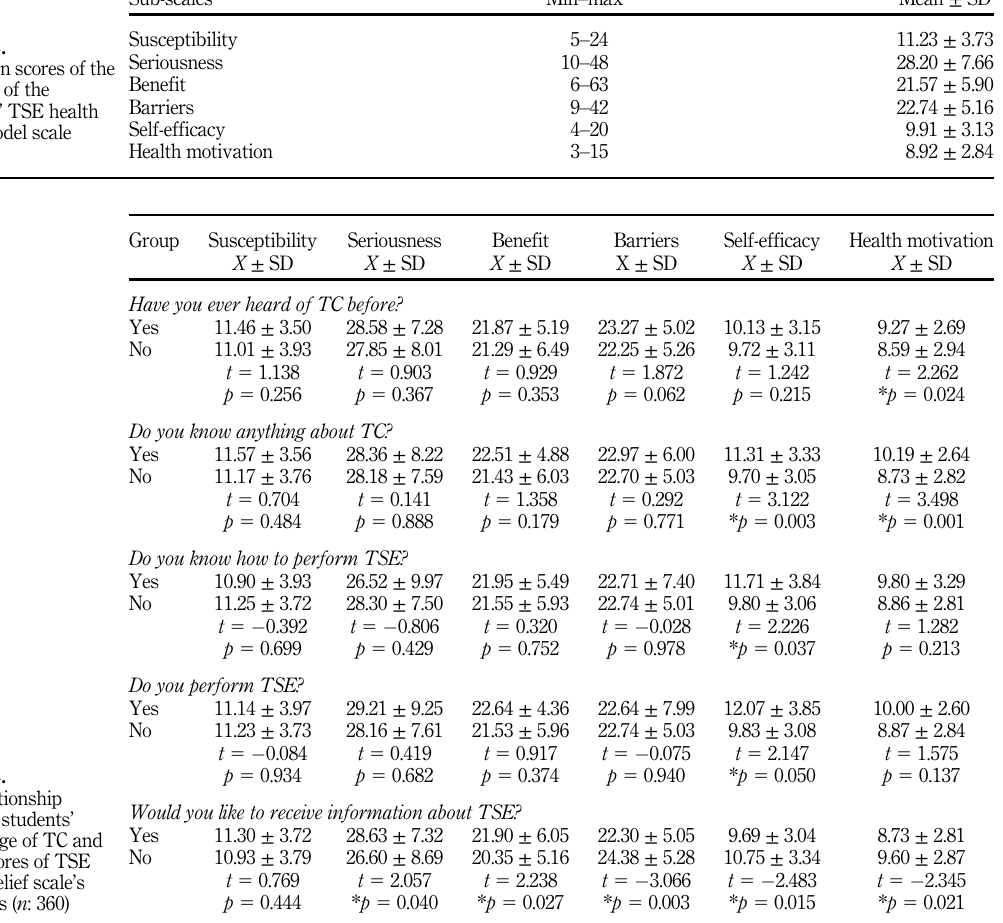
Table 4. The relationship between students ’ knowledge of TC and mean scores of TSE health belief scale ’ s subscales ( n :